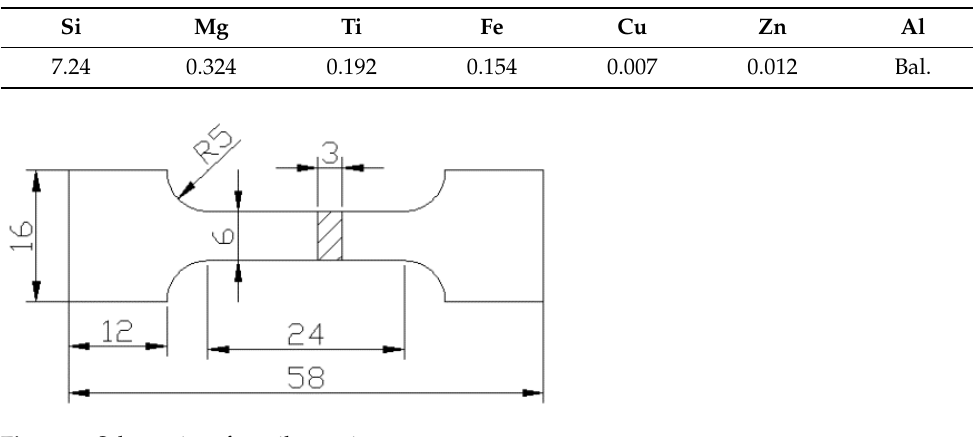
Figure 1. Schematics of tensile specimens.